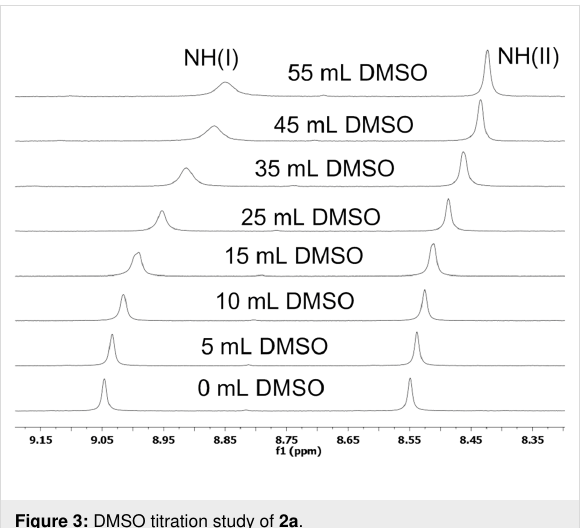
Figure 3: DMSO titration study of 2a